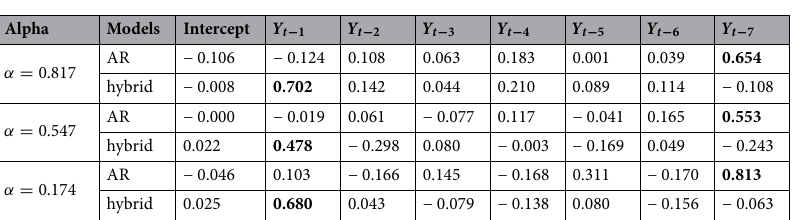
Table 3. Coefficients of AR model v.s. AR coefficients of hybrid model. When AR component dominates the prediction ( α = 0.817 ), MAPE for AR and hybrid are 3.088% and 2.593%. When the AR and the LSTM components have similar weight in prediction ( α = 0.547 ), MAPE for AR and hybrid are 2.523% and 1.950%. When LSTM component dominates the prediction ( α = 0.174 ), MAPE for AR and hybrid are 9.337% and 4.665%. Coefficients with biggest absolute values are given in